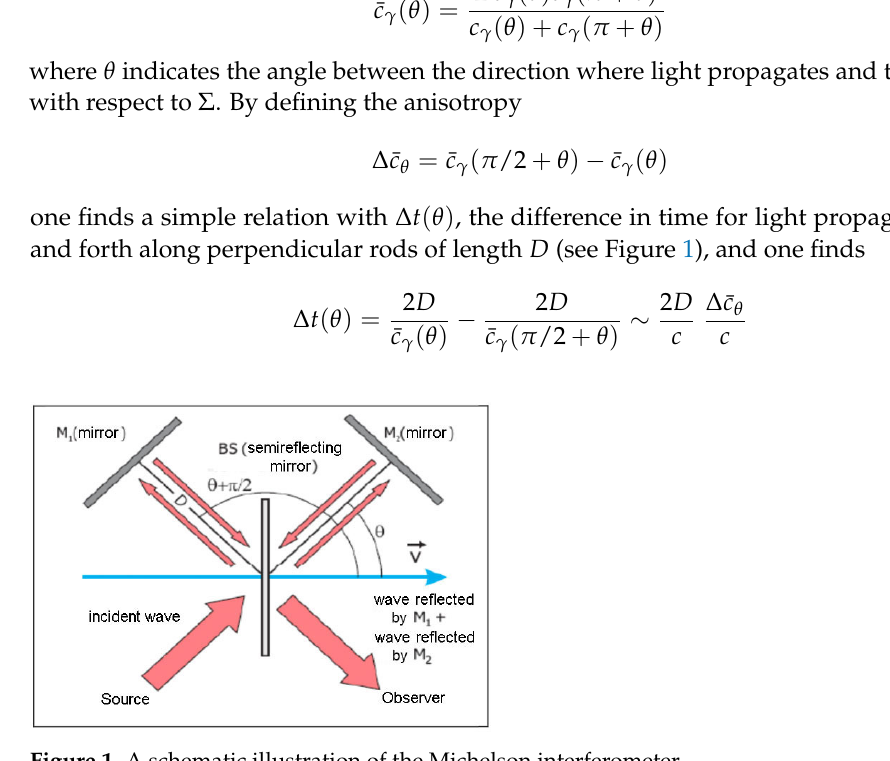
Figure 1. A schematic illustration of the Michelson